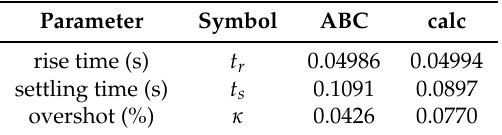
Table 5. Values of step-response indicators obtained for both considered methods for step change of reference signal (simulation case).